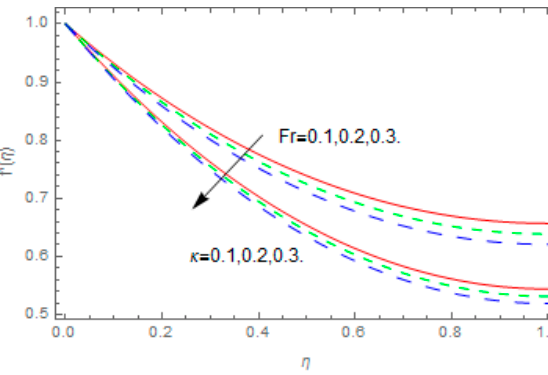
Figure 3. Impression of n and M on f (cid:48) ( η ) .